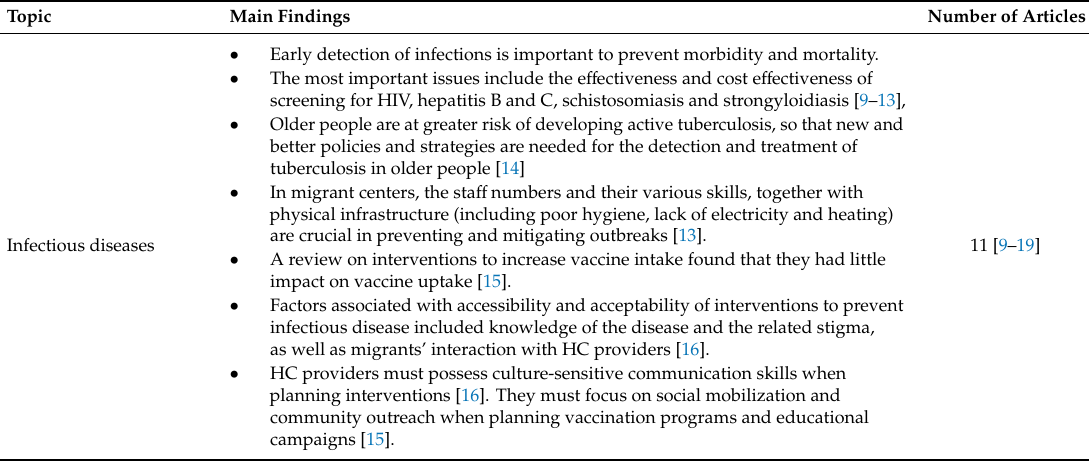
Table 1. Summary of special issue manuscripts, arranged according to principle